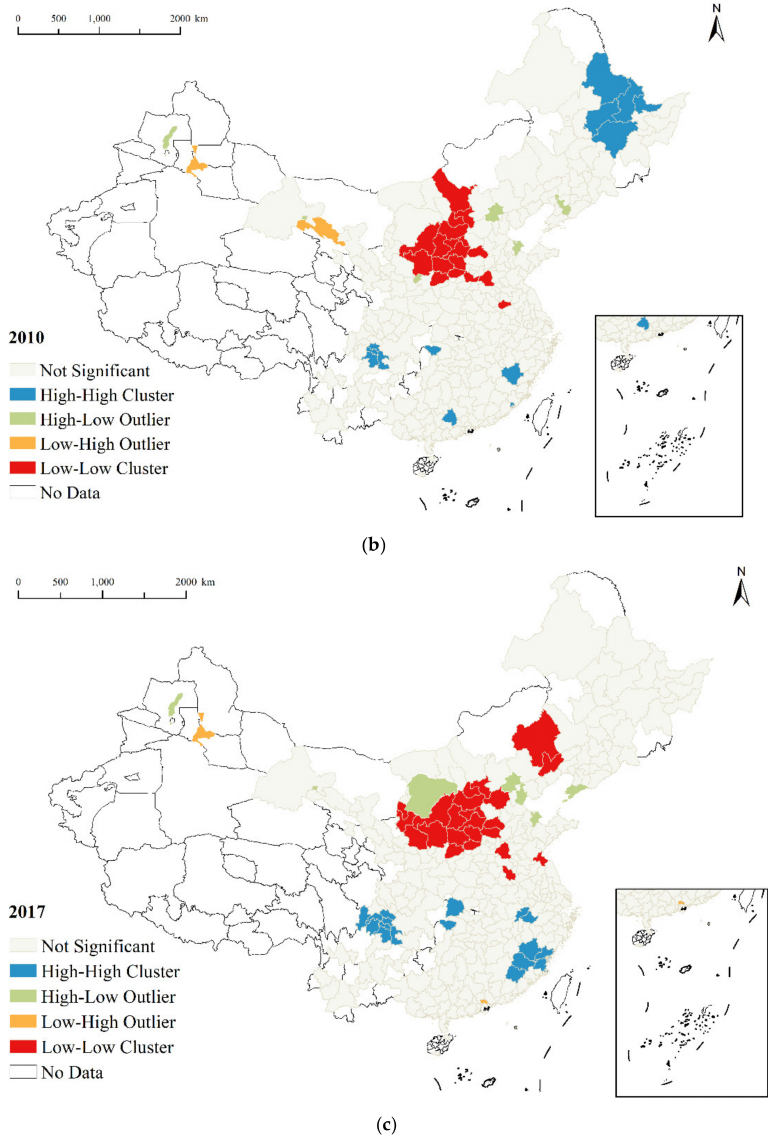
Figure 5. LISA map of city-level CE in ( a ) 2003, ( b ) 2010, and ( c )